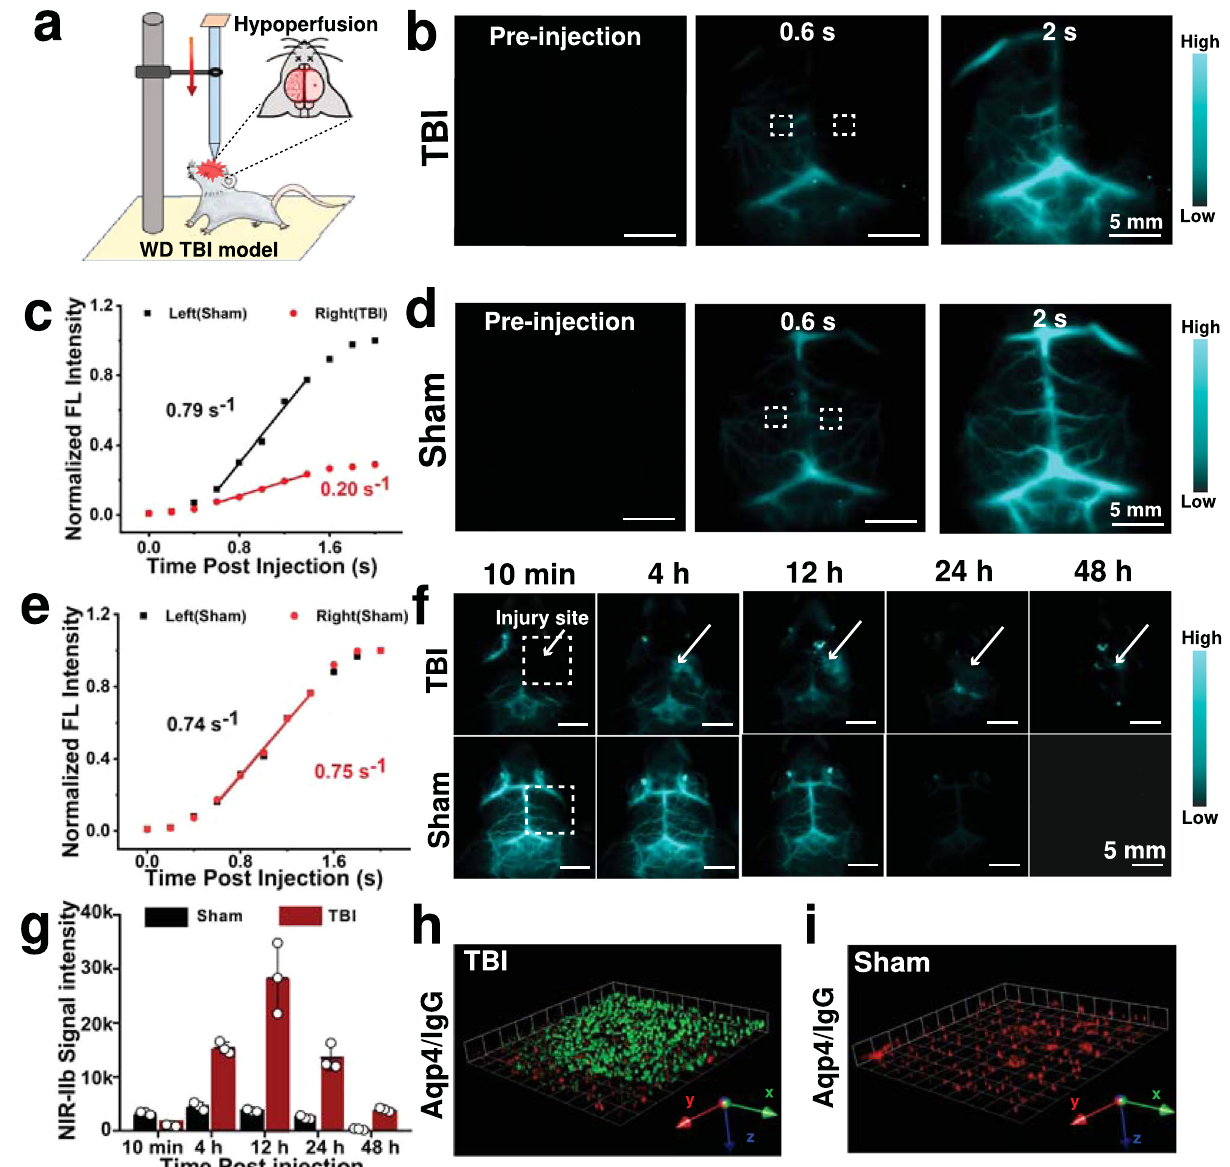
Fig.4|Dynamicandhigh-resolutionNIR-IIbimagingformonitoringthestatusof BBB in acuate phase of TBI. a Schematic displaying the experimental procedure forthe WD TBI model. b DynamicNIR-IIb imageframesrecorded atindicatedtime points post injection of Mn/QD SAC with TBI mouse. The ROI is outlined by white dotted lines. c NIR-IIb signals in the left (contralateral) and right (ipsilateral) cere- bralhemispheresoftheTBImouseversustimeaccordingtothepanel b . d Dynamic NIR-IIb image frames recorded at indicated time points post injection of Mn/QD SAC withhealthy mouse with sham treatment. The ROI is outlined by white dotted